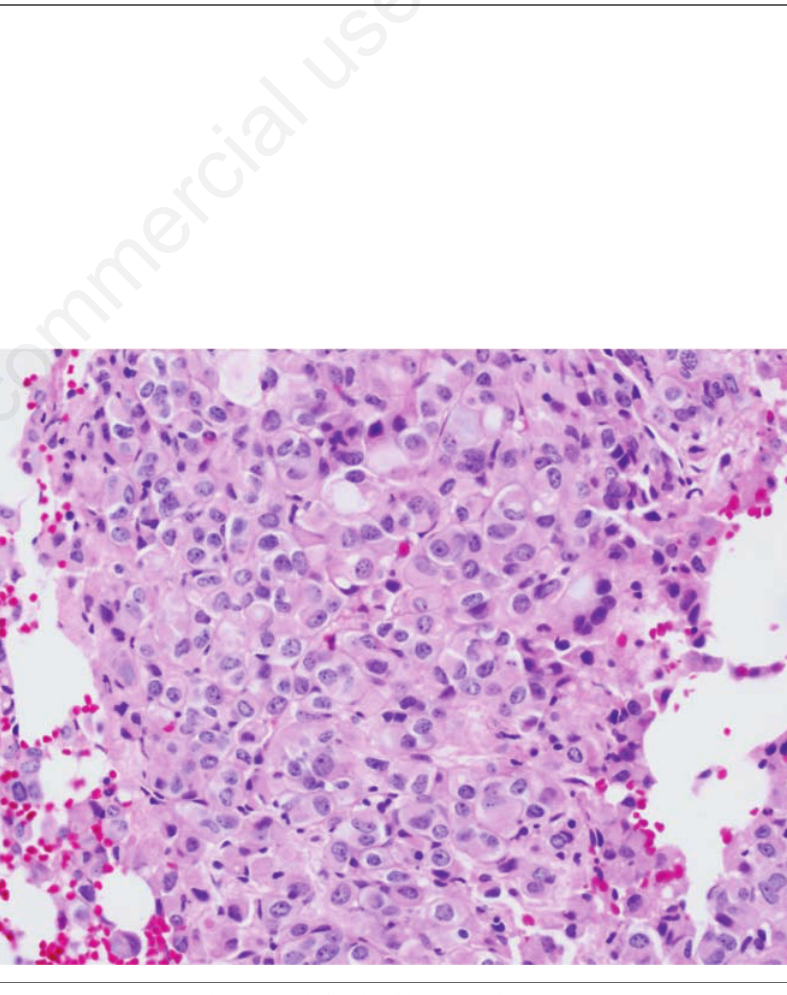
Figure 2. Bone marrow biopsy with focal infiltration of